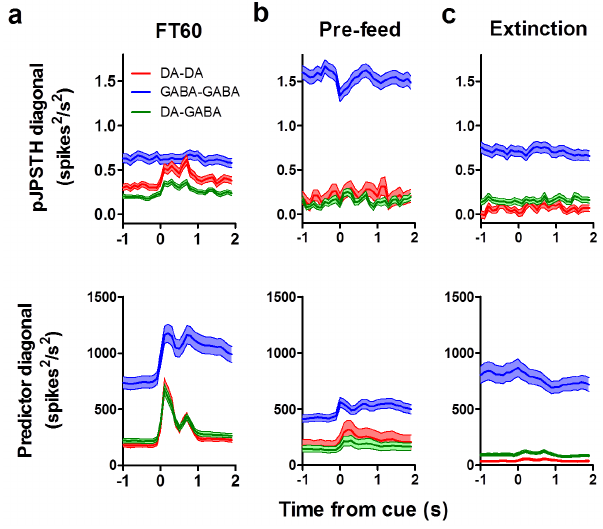
Figure 14. Cue-elicited synchrony of neural activity is also modulated by motivational state. pJPSTH diagonals (mean 6 s.e.m.; 100 ms 6 100 ms bins; 500 ms diagonal width) are shown for DA-DA ( n= 185 FT60; n =81 pre-feed; n =45 extinction), GABA-GABA ( n= 475 FT60; n =346 pre-feed; n =389 extinction), and DA-GABA ( n= 394 FT60; n =144 pre-feed; n =138 extinction) pairs recorded during FT60 ( a ), pre- feeding ( b ), and extinction ( c ). The diagonals of the corrected and normalized pJPSTHs are in the top row, while the diagonals of the predictor matrices are in the bottom row. The predictor was defined as the cross-product of the JPSTH for each pair of neurons. Pre-feeding reduced cue-elicited synchrony for DA-DA and DA-GABA pairs while increasing overall synchrony between GABA-GABA pairs ( b ). Extinction reduced synchrony between DA-GABA and DA-DA pairs without affecting GABA-GABA pairs ( c